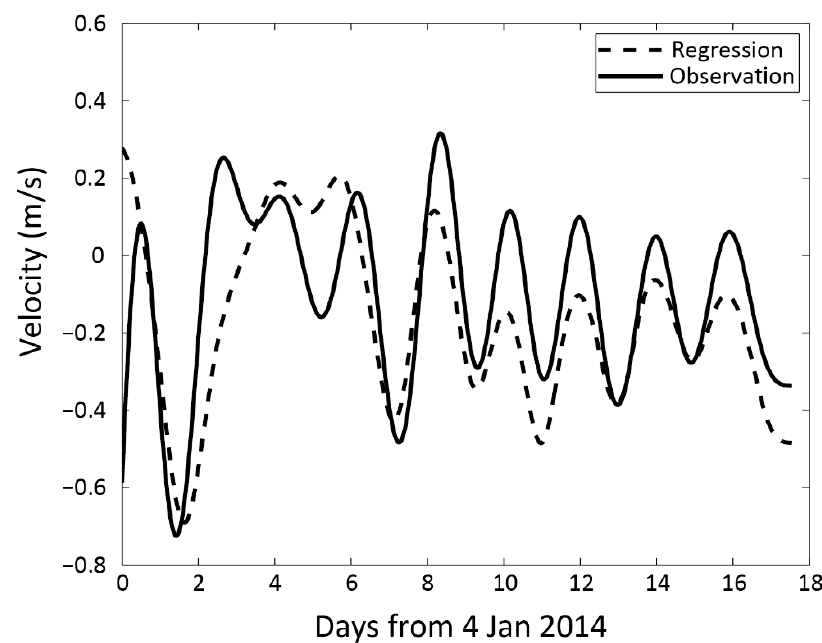
Figure 10. The regression curve compared with observations. The bold line is from observations and the dashed line is from the regression equation.